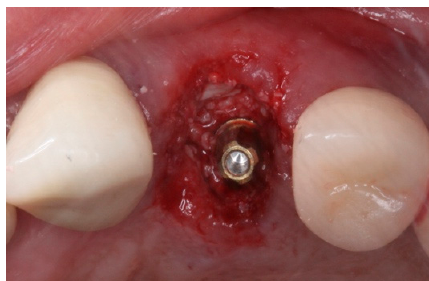
Figure 7. Immediate implant grafted with xenograft material. Note that the prosthetic abutment was installed to receive the interim prosthesis.